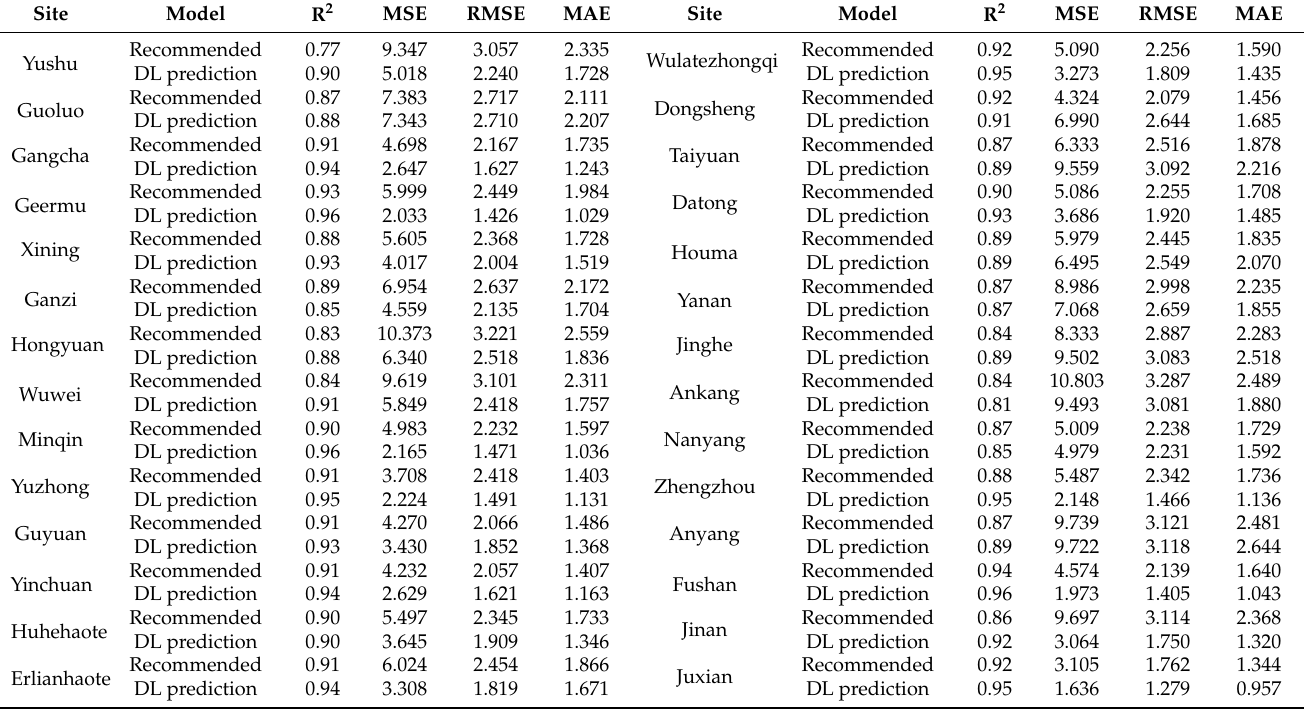
Table 3. Performance comparison between the prediction results of the recommended values of station Å-P parameters and the prediction results of the DL